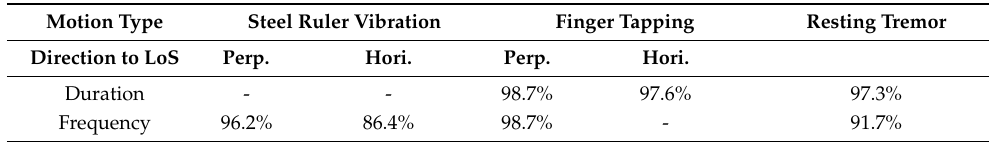
Figure 9. The processed CSI data of the target motion parallel to LoS demonstrates the directional effect. The red circles in ( a ) indicate peaks in the data identified by our algorithm and are used to count the number of movements. Peaks are not annotated in ( b ) as they are poorly found by the algorithm due to the directional effect of motion. ( a ) Steel ruler vibration. ( b ) Finger tapping. Table 4. Sensing accuracy of the proposed approach for detecting the three types of motion perpen- dicular and parallel to